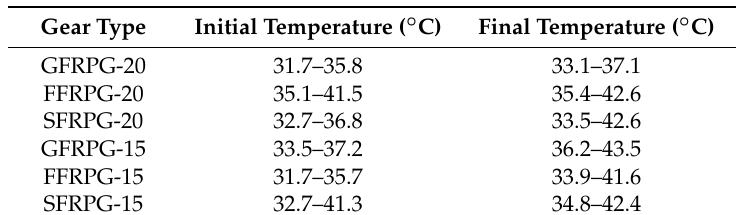
Table 2. Temperature rise in gears after running for 1 h at 150 rpm. Flax fiber-reinforced polyester gear